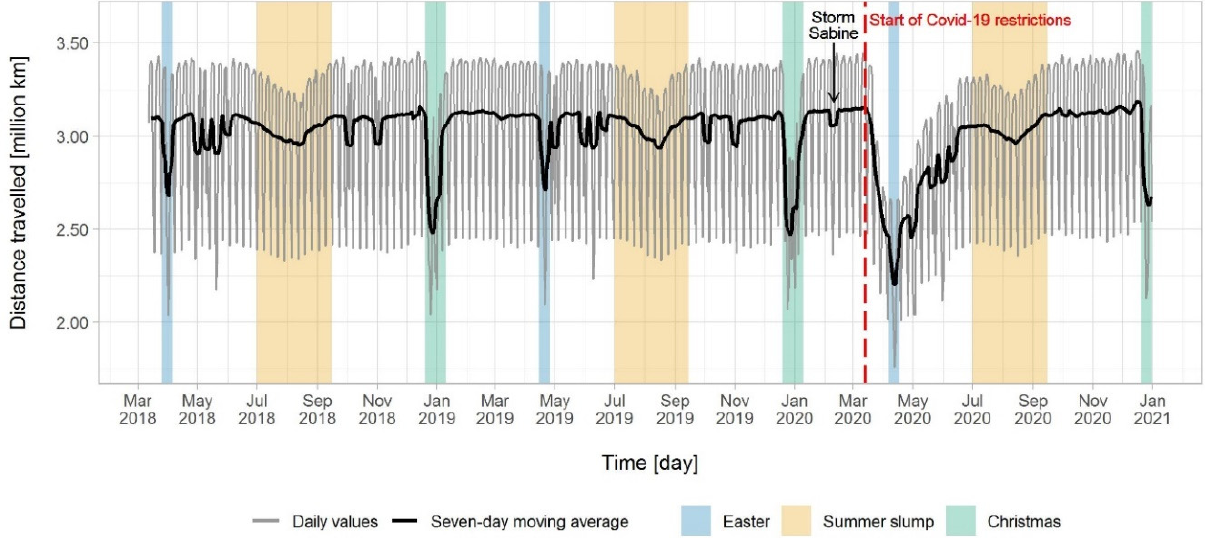
Figure 2. Total distance travelled throughout the Deutsche Bahn (DB) railway network over time.